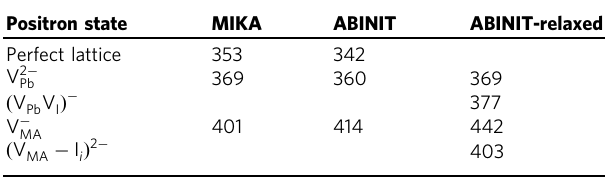
Table 1 Calculated positron state lifetimes (ps) for perfect lattice and cation vacancy defects in MAPbI 3